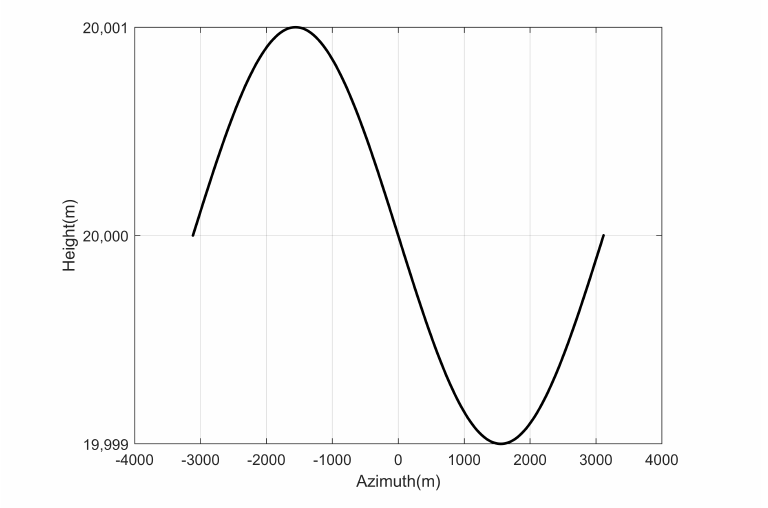
Figure 15. The curved trajectory of the moving platform.